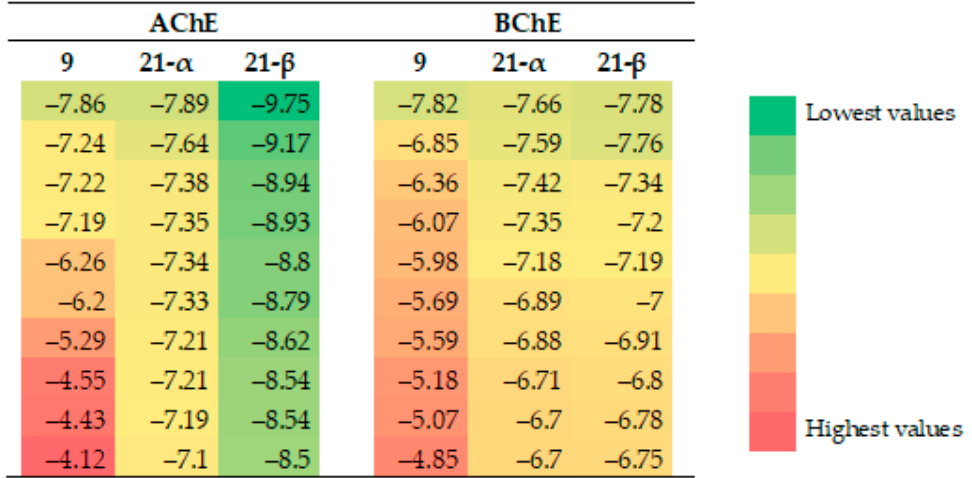
Figure 4. Binding energies (kcal/mol) of the top docking poses of compounds 9 , 21- α and 21- β into AChE and BChE.